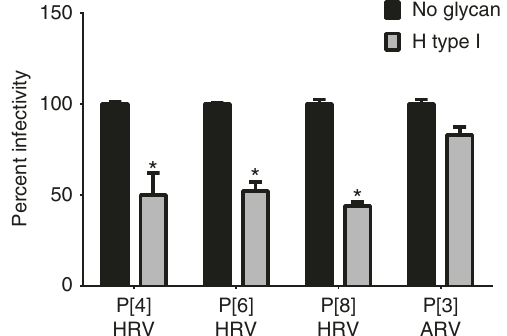
Fig. 6 H-type I glycan inhibits infectivity of the prevalent HRVs. PAA- conjugated H-type I (1 mg/ml) signi fi cantly reduced the infectivity of P[4], P[6], and P[8] HRVs but not of a P[3] animal rotavirus (ARV, RRV strain). Each bar represents mean % infectivity, with no glycan treatment considered to be 100%. All assays were carried out a minimum of two times, with triplicates within each experiment. Error bars represent standard error of the mean. P -values < 0.05 were considered statistically signi fi cant [analysis of variance (ANOVA) with Sidak ’ s correction for multiple